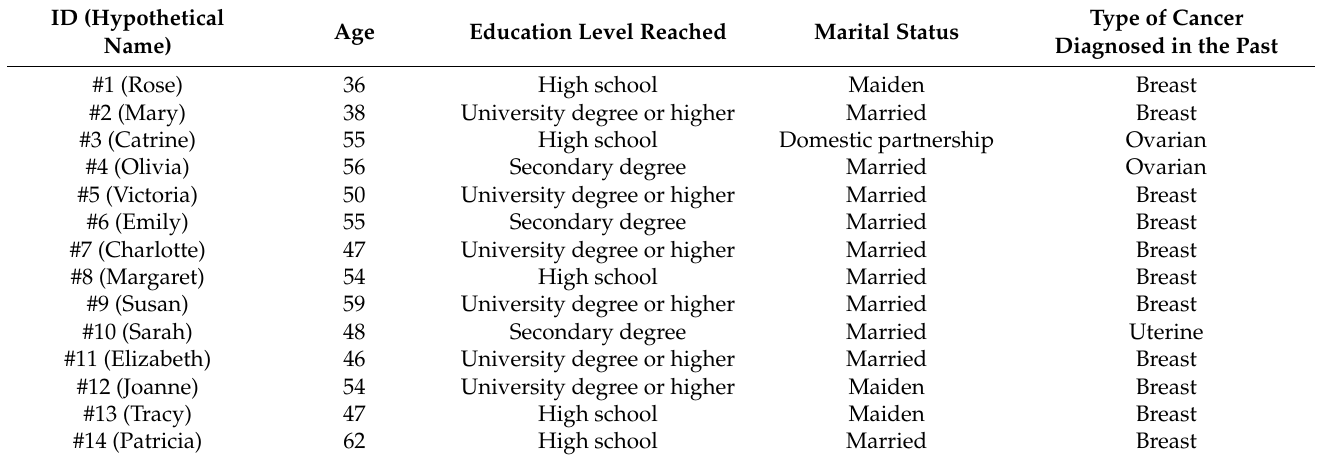
Table 2. Participant